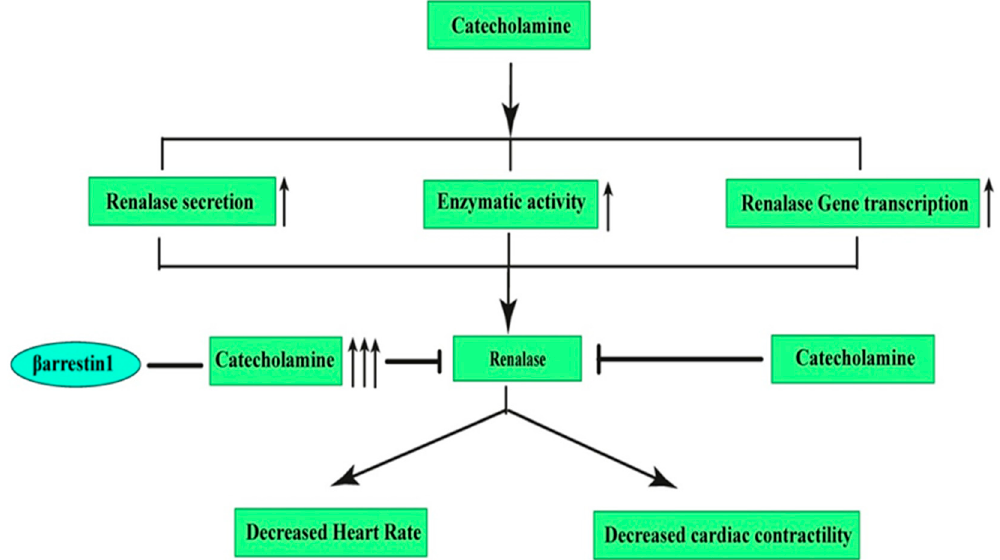
Figure 5. The renalase pathway. Catecholamines stimulate renalase synthesis through increasing renalase secretion from prorenalase, increased enzymatic activity, and enhanced gene transcription. Activated renalase then degrades catecholamines into their metabolites. Renalase decreases hypertension by decreasing the heart rate and cardiac contractility. However, β -arrestin1 expression causes an excessive amount of catecholamine synthesis, which further inhibits the beneficial action of renalase.